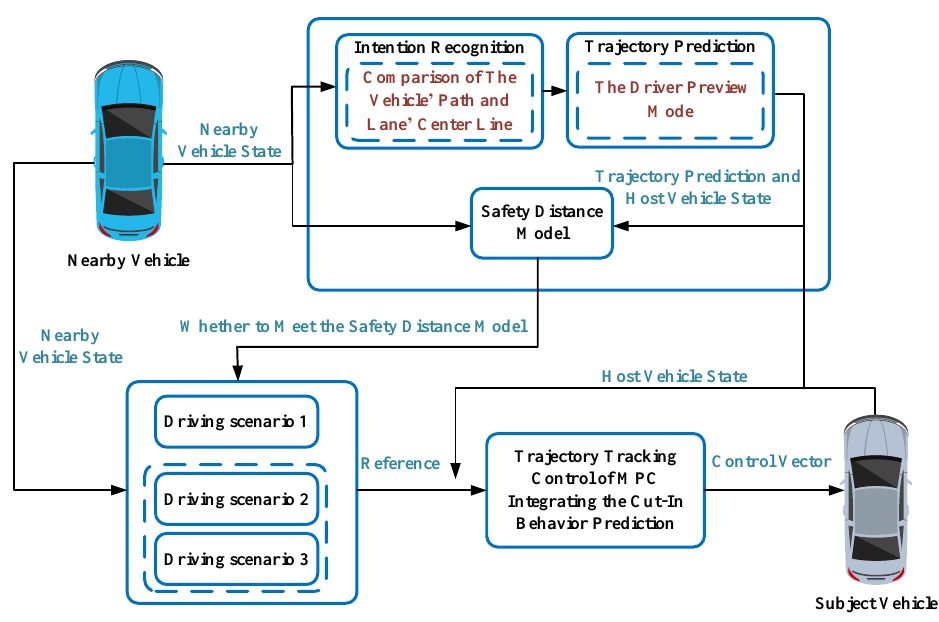
Figure 1. Trajectory tracking control architecture.